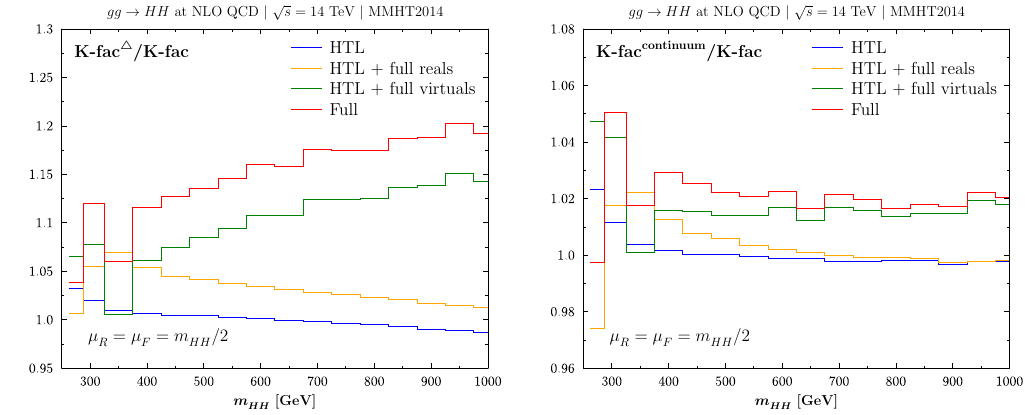
Figure 13 . Ratios of the K-factor including (left) only triangle diagrams and (right) only continuum diagrams to the full K-factor of Higgs-pair production as a function of the invariant Higgs-pair mass Q = m HH for the LHC with a c.m. energy p s = 14 TeV and using MMHT2014 parton